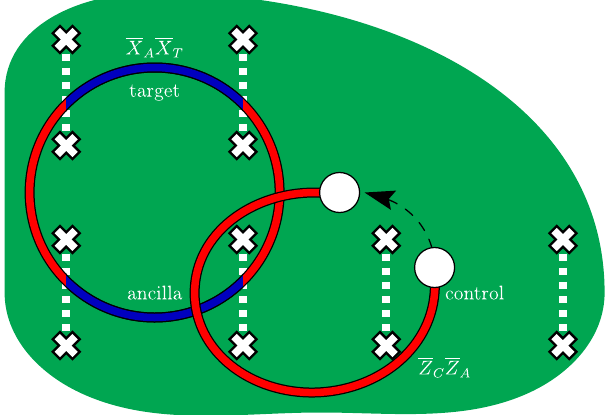
FIG. 14. Executing the two qubit parity measurements, we need to perform a controlled-NOT gate. Qubits are encoded with quadruples of twists, where the different logical qubits — the control, target, and ancilla — are labeled in the center of each twist ¯ Z ¯ Z quadruple. We measure C A by braiding a single hole of a hole- pair qubit around two twists of the control qubit and two twists of the ancilla qubit, as shown in the figure. Upon completing this deformation, measuring the hole-pair qubit reveals the outcome ¯ X ¯ X of the parity measurement. We also show the A T operator that we must measure. This is again achieved by braiding one hole of ¯ X a hole pair, which is prepared in around the loop followed by ¯ X ¯ X ¯ Z the A T operator. Measuring A completes the controlled-NOT gate, up to a Pauli